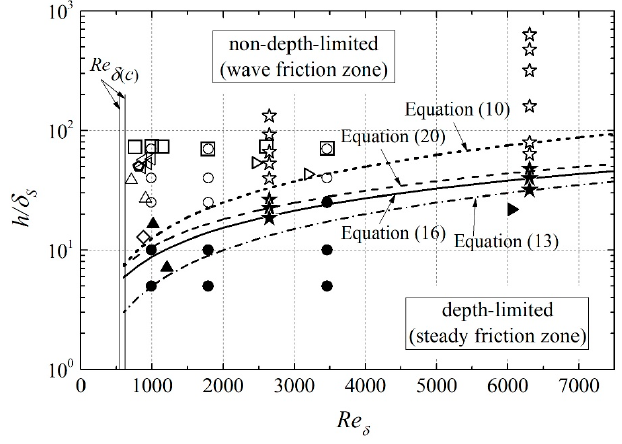
Figure 7. Demarcation in terms of Re δ and h / δ s . For an explanation of symbols see Tables 1 and 2.